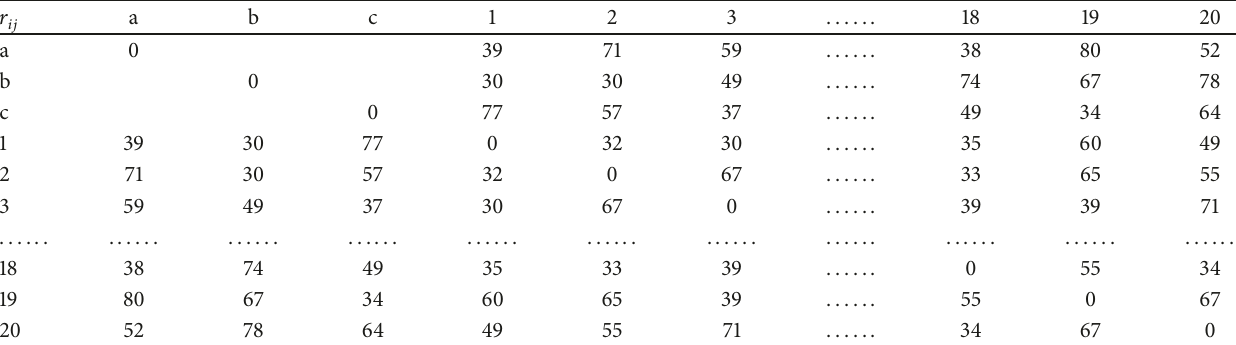
Table 2: The nominal transportation risk value of hazmat.